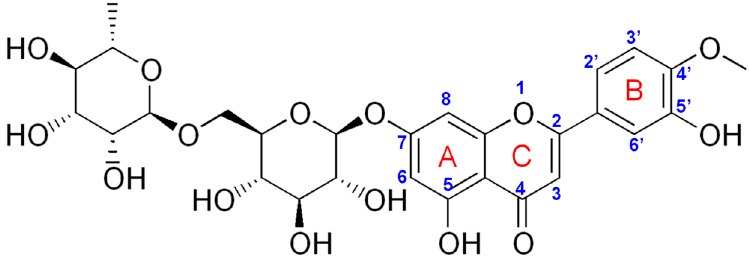
Figure 1. Chemical structure of diosmin (DIO).